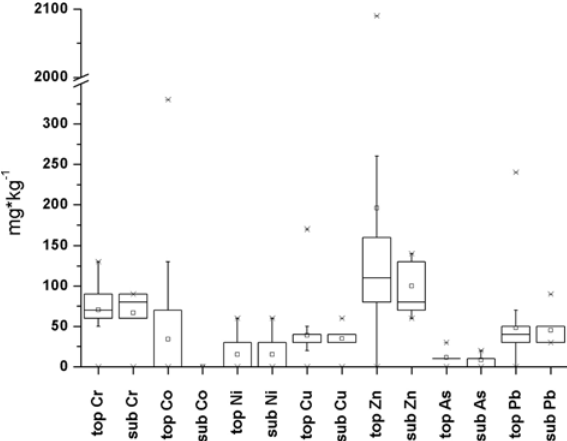
Fig. 8. Concentration of heavy metals in the subsurface and in the